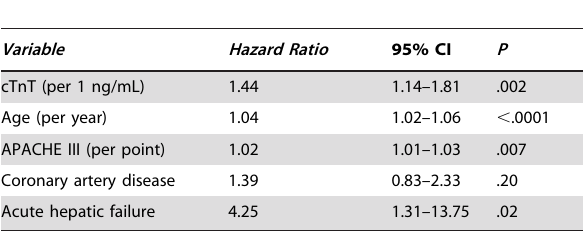
Table 2. Results of Cox proportional hazards model for association of elevated cardiac troponin T level with 60-day